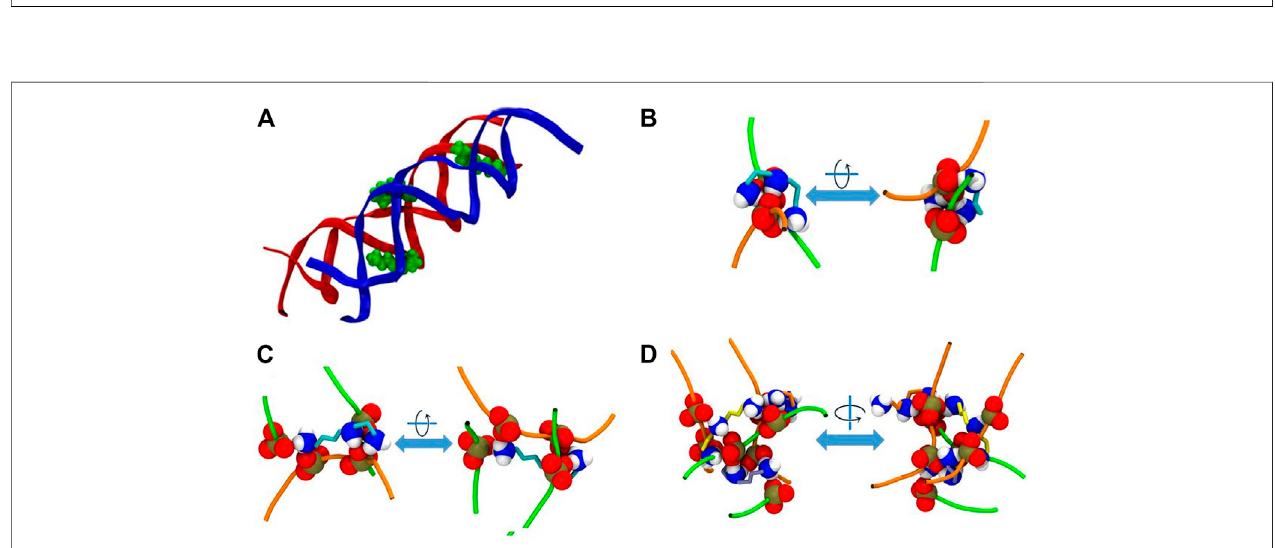
FIGURE11| Representativeinteractionmodes ofSpd 3+ withDNAhelices. (A) Snapshotdepictingtheparallel-perpendicular(pp) conformationoftheSpd 3+ inthe DD-20 Å system. The DNA backbone is represented in red and blue, Spd 3 green VdW spheres. (B) Detail depicting a C-shaped Spd 3+ that mediates the contact between two phosphate groups, one from each DNA molecules. (C) Detail depicting a Spd 3+ molecule in the pp conformation that mediates the contact between four phosphategroups,twofromeachDNAmolecules. (D) DetaildepictingacontactpointbetweenthetwoDNAmolecules.ThreeSpd 3+ mediatethiscontactpointby interactingwith7PO 3 groups.In (B – D) DNAbackbonesaredepictedasanorangeandgreentube,onecolorforeachmolecule,whiletheNH 3 ,NH 2 andPO 3 groupsare represented as VdW spheres and the C atoms of Spd 3+ are represented with licorice in teal, orange, and yellow color. Larger representation of the snapshots can be found in the Supplementary Figures S11 – S14